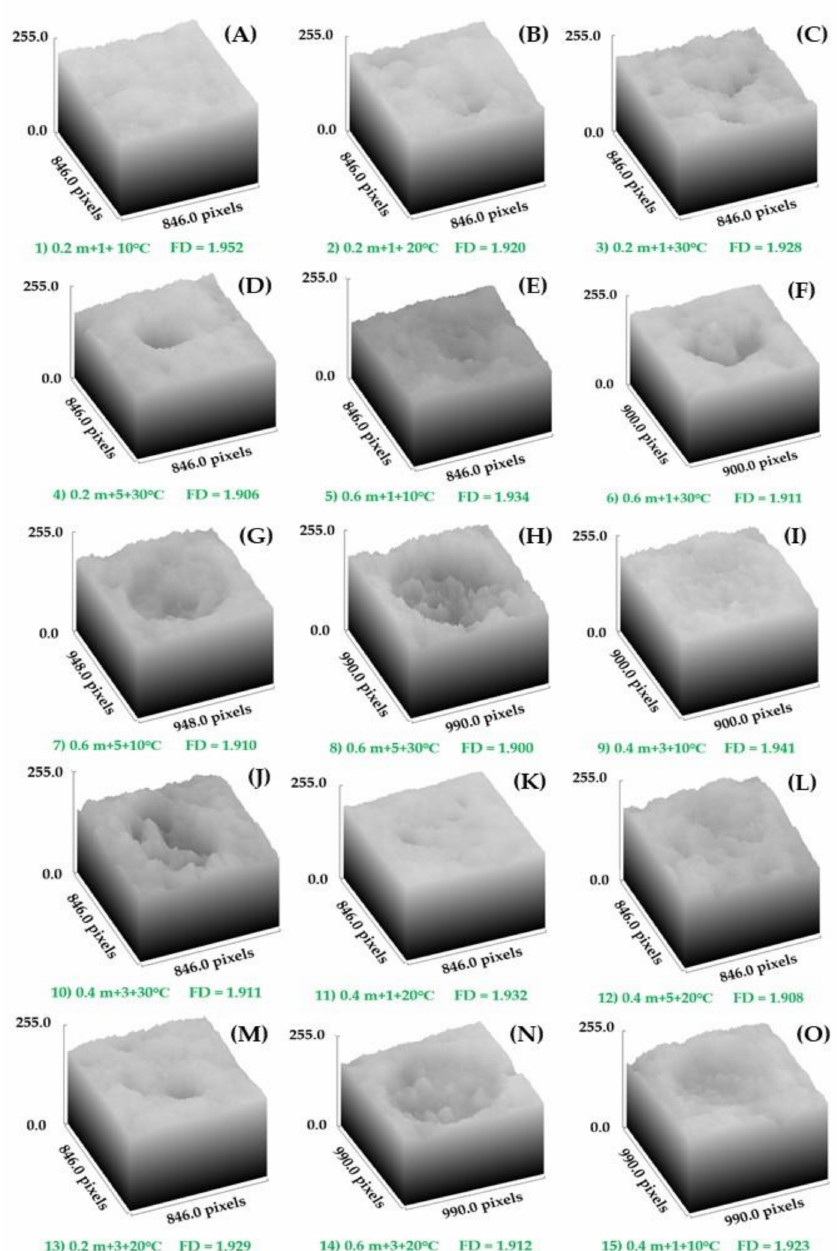
Figure 4. Fifteen pictures of fractal dimension (FD) of surface plots in impact bruising of guava for different drop heights, number of drops, and storage temperature variables under RSM design from fifteen runs (treatments) after storage for 48 h. The fifteen runs were 0.2 m + 1 drop + 10 ◦ C ( A ), 0.2